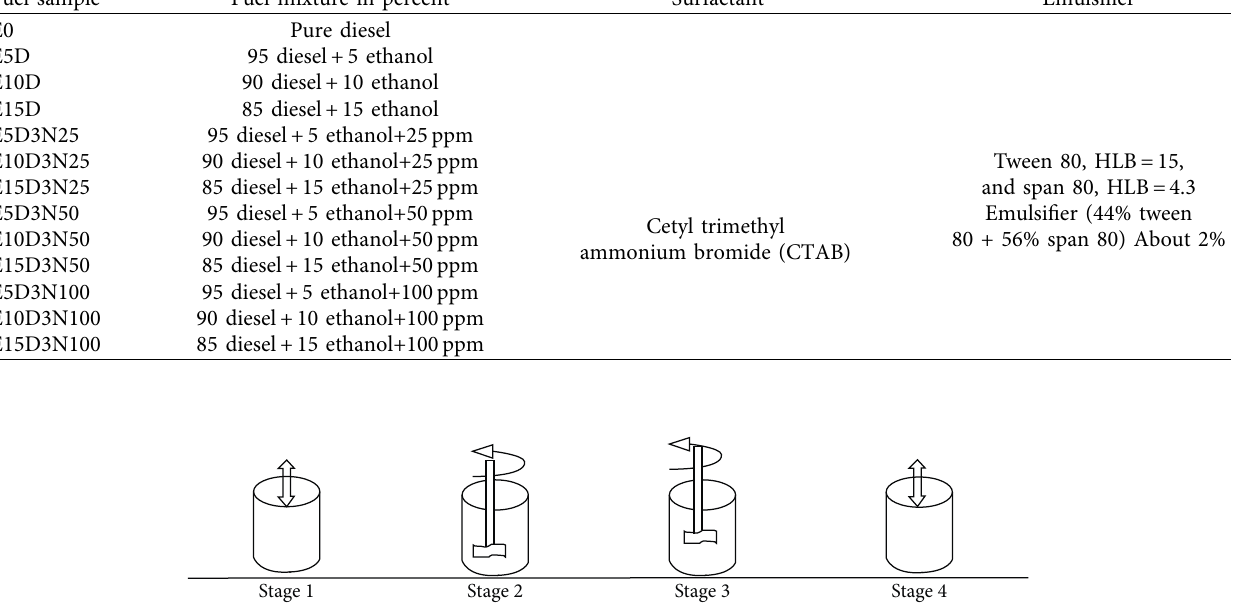
Figure 4: Stage-by-stage emulsion preparation process. Table 7: Operating conditions for emulsified fuels preparation.